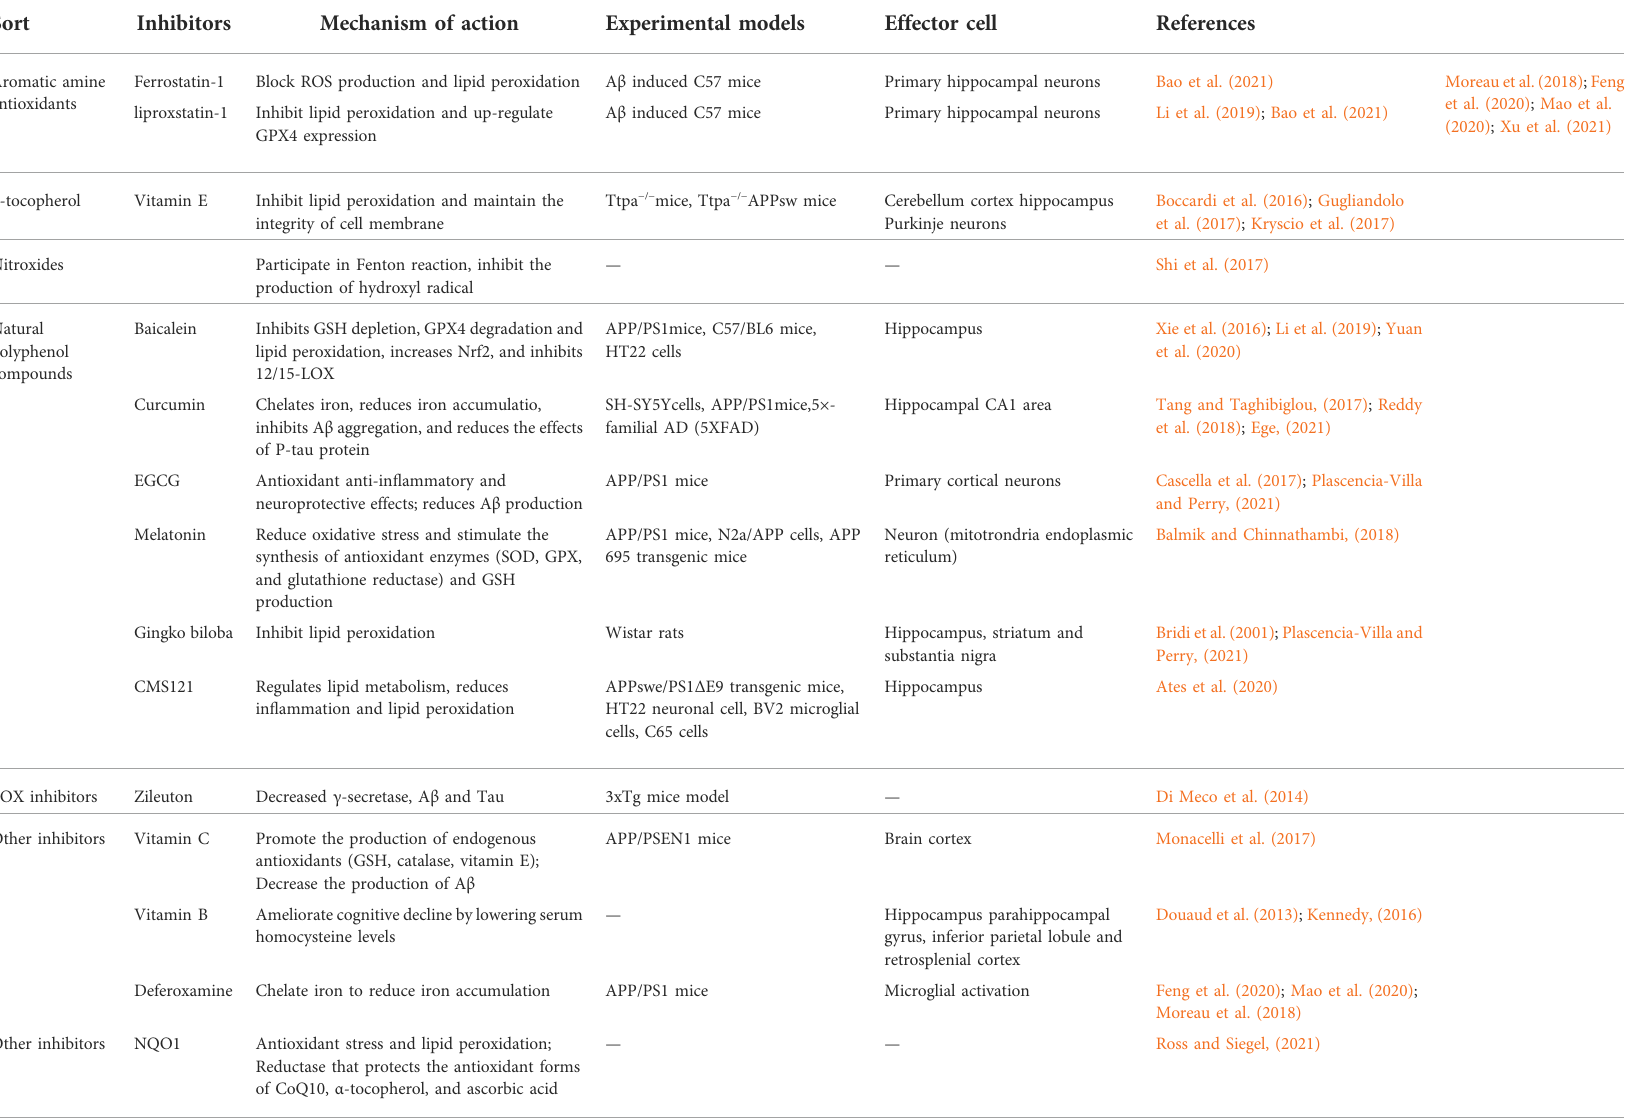
TABLE 1 Summary of the available ferroptosis Inhibitors in Alzheimer